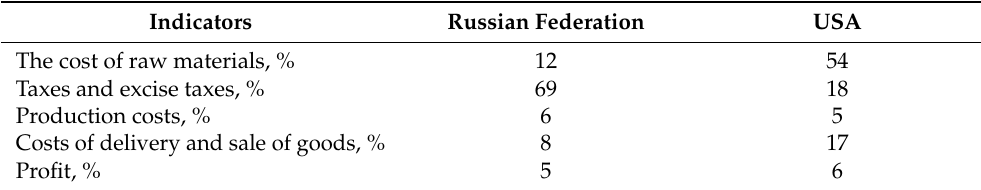
Table 4. The structure of the average cost of 1 L of gasoline in Russia and the USA, 2020. Indicators Russian Federation USA The cost of raw materials, % 12 54 Taxes and excise taxes, % 69 18 Production costs, % 6 5 8 17 5